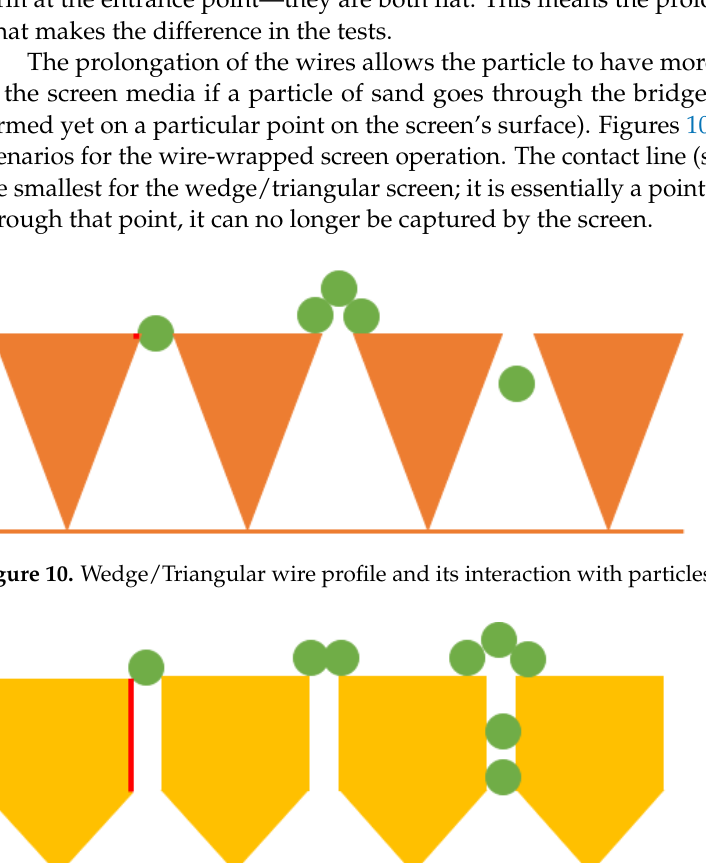
Figure 12. Drop-shaped wire profile and its interaction with particles. The contact line of the trapezoidal profile is the largest. Thus, particles can be stuck easily two or more times during their path through the screen. The drop-shaped profile has a mediocre size of the contact line. Thus, it should be positioned between the previous two wire profiles in terms of produced sand and retained permeability[53]. The difference for produced sand can be observed in Figures 6 and 7, and one can say that it is fair, however, the retained permeability is not that simple due to the complex nature of the sanding process and the inability of scientists to duplicate the results on a constant basis due to sand mixture during core rock model preparations. Another item of concern is a particle ’s “roundness”, which can be measured via the aspect ratio and sphericity ratio of the particle [17]. Roundness should have a higher effect on screens with higher outer diameters of the screen opening, compared to inner diame- ters. This mostly applies to a drop-shaped profile of the wire. This is mostly due to the high open to flow area of the drop-shaped screen on the outer area. Thus, if it will be properly blocked by a particle of an irregular shape, it will have higher permeability com- pared to other wire profiles (and screens made of them) in general. The height of the opening also increases the overall strength of the wire-wrapped screen (due to the higher content of metal, compared to other screens), which makes it more reliable in terms of installation failures and helps to ensure the screen ’ s efficiency, saving even in emergency situations. In this study, core rock models were made of the same rock. Thus, it was impossible to study the effect of particle shape parameters on the screen efficiency of different wire profiles. Due to the differences in inner and outer diameters of the wire-wrapped screens of all profiles, the results would differ between them. From a logical point of view, a drop-